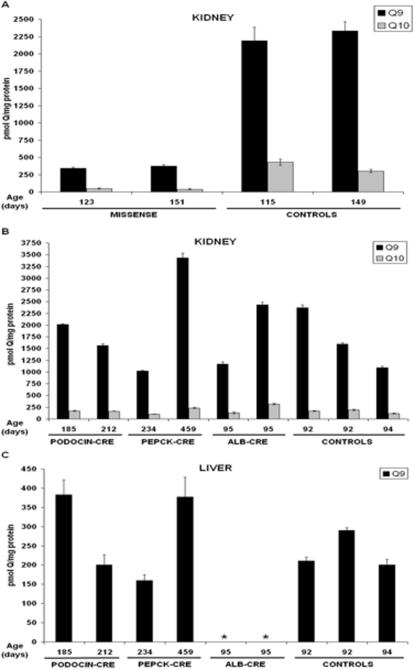
CoQ Measurements in Pdss2 Missense, Conditional Knockout, and Strain-Matched Control Mice.CoQ measurements in Pdss2kd/kd; Podocin/cre,Pdss2loxPloxP; PEPCK/cre,Pdss2loxPloxP; Alb/cre,Pdss2loxP/loxP; and strain-matched control mice (B6 and B6.Pdss2loxPloxP). A, Kidney levels of CoQ9 and CoQ10 are significantly lower in B6.Pdss2kd/kd (missense) mice than in B6 control mice. B, Kidney levels of CoQ9 and CoQ10 are similar in B6.Podocin/cre,Pdss2loxPloxP; B6.PEPCK/cre,Pdss2loxPloxP; B6.Alb/cre,Pdss2loxP/loxP; and control mice. The 92-day-old controls are B6.Pdss2loxP/+, and the 94-day-old control is B6.Pdss2loxP/loxP. C, Liver levels of CoQ9 in B6.Alb/cre,Pdss2loxP/loxP mice were below 30 picomoles/mg protein (*) while these same levels in B6.Podocin/cre,Pdss2loxPloxP and B6.PEPCK/cre,Pdss2loxPloxP mice were similar to those in control mice. The strains of the control mice in are the same as those in panel B.